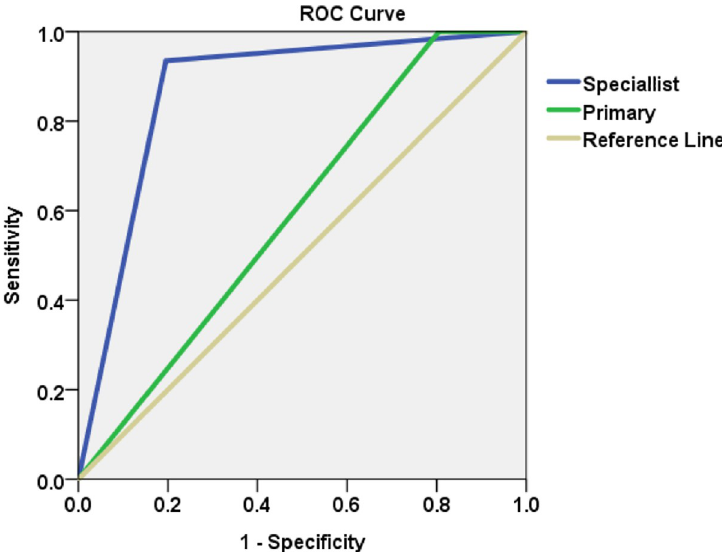
Fig 3. Receiver operating characteristic curve for comparison of the diagnostic accuracy of the primary examiner and the specialist. The area under curve (AUC) for the specialist (blue) and primary examiner (green) were 0.870 and 0.598, respectively; log-rank test comparing the specialist and primary examiner was significant (p < 0.001).